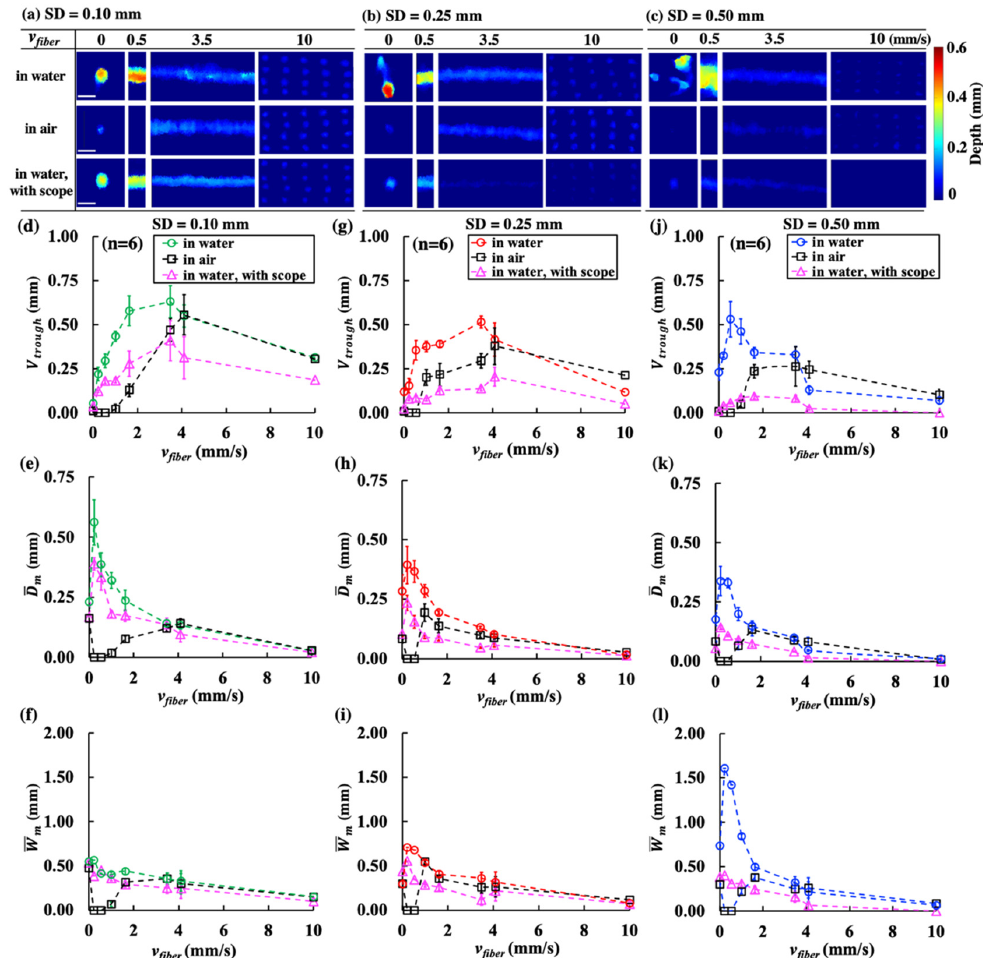
Figure 4. OCT reconstruction of damage patterns on BegoStone surfaces produced by 100 pulses (0.2 J and 20 Hz) in water and in air without scope, and in water with scope at OSD = 0.25 mm delivered at ( a ) SD = 0.10 mm, ( b ) SD = 0.25 mm, and ( c ) SD = 0.50 mm (scale bar = 1 mm). Trough volume ( V trough ) ( d , g , j ), mean trough depth ( D m ) ( e , h , k ), and mean trough width ( W m ) ( f , i , l ) are plotted vs. v fiber